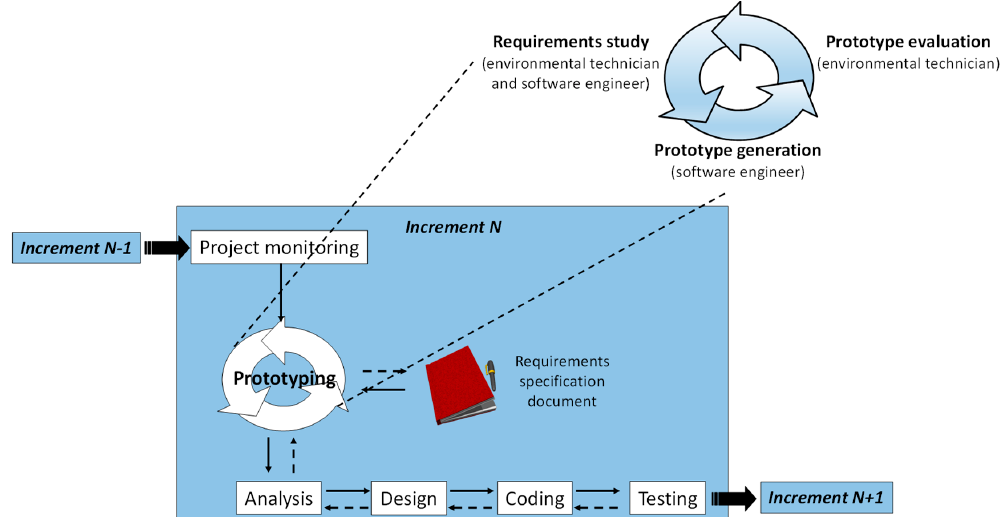
Figure 2. Process followed in SCALA © development.